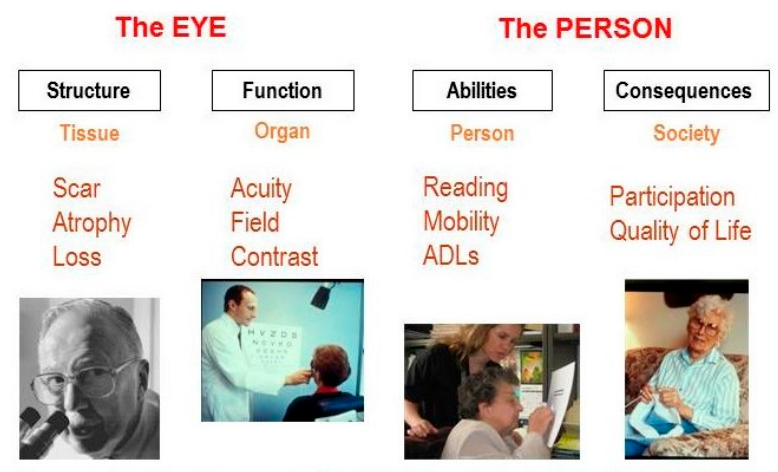
Figure 1. Aspects of visual functioning.